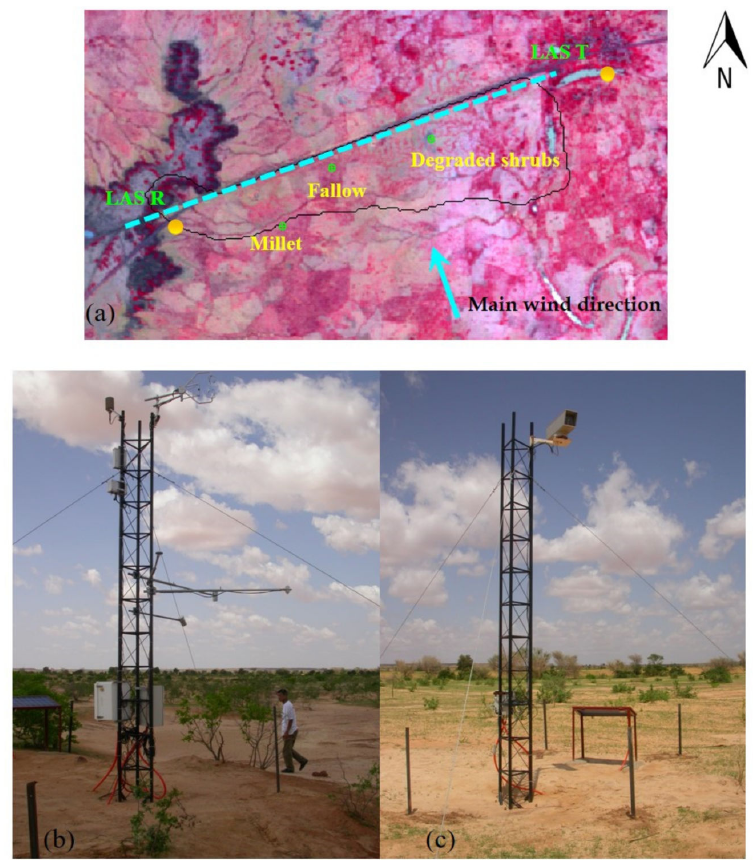
Figure 2. ( a ) An overview of the Wankama basin and the experimental setup, locations of LAS (T and R stand for transmitter and receiver, respectively) and three EC systems are shown (millet, fallow and degraded shrubs sites). Photos (EC system ( b ) and scintillometer ( c )) were taken by J. Ezzahar as part of the ACN